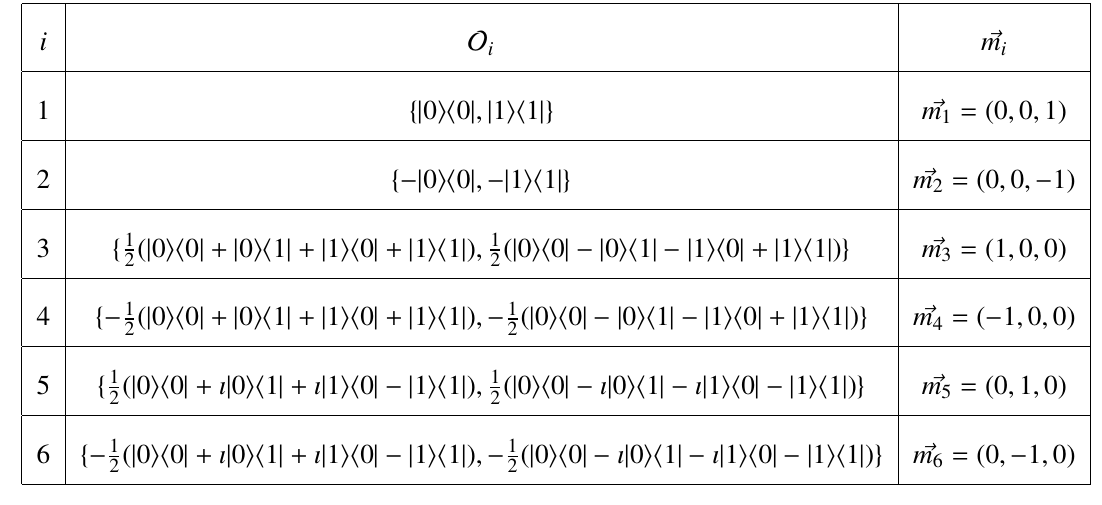
Table 2: All possible mutually unbiased operator bases for local dimension 2 are specified here for Bob. Corresponding direction ⃗ m of projective measurement ⃗ m .⃗σ is given. Clearly, up to global phase, the three possible MUB operator bases are given corresponding to directions ⃗ m 1 , ⃗ m 3 and ⃗ m 5 . Each of three measurement directions of Bob is thus given by third column of the table, i.e., ∀ j = 1 , 2 , 3 , ⃗v j ′ ∈ { ⃗ m 1 , ⃗ m 2 , ⃗ m 3 , ⃗ m 4 , ⃗ m 5 , ⃗ m 6 } . As Bob performs three measurement in MUBs, so if ⃗v 1 ′ is one of ⃗ m 1 or ⃗ m 2 (say), then ⃗v 2 ′ (cid:44) ⃗ m 1 , ⃗ m 2 . It can be any one of from ( ⃗ m 3 , ⃗ m 4 ) or from ( ⃗ m 5 , ⃗ m 6 ). If say ⃗v 2 ′ = ⃗ m 3 , then ⃗v 3 ′ is any one of ⃗ m 5 or ⃗ m 6